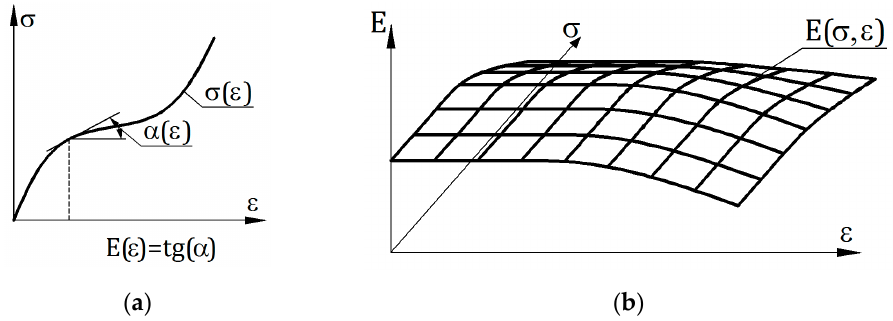
Figure 27. Description of material stiffness: ( a ) classic—stiffness is a function of one variable; ( b ) matrix—stiffness is a function of two variables.